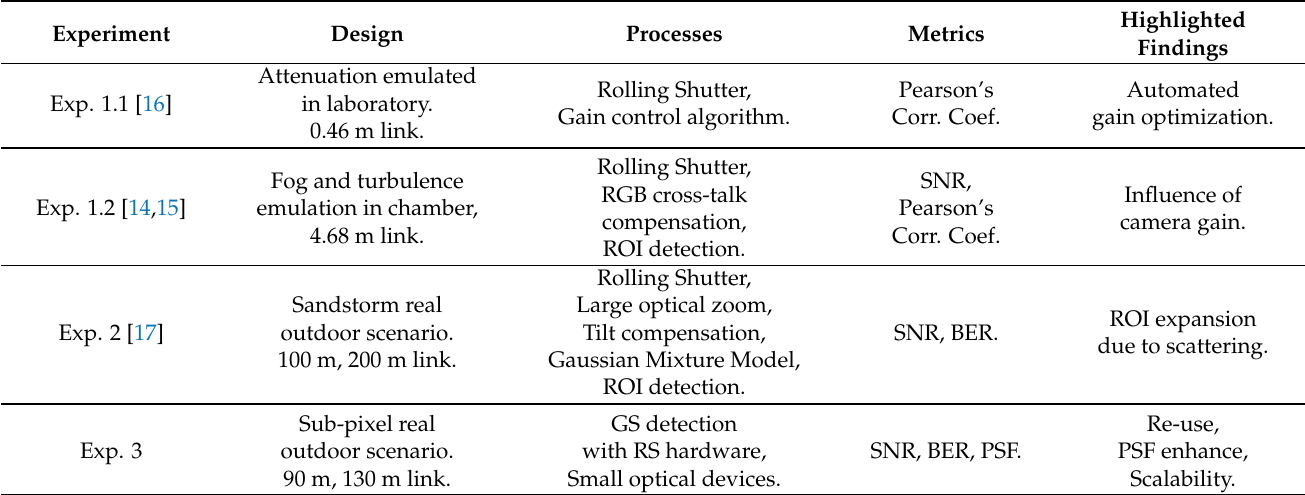
Table 2. Summary of the experiments carried out, with their key contributions on methodology and results.